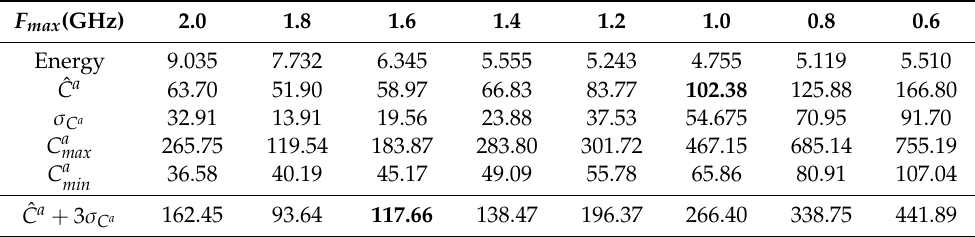
Table 5. Values obtained for performance governor with di ff erent F max values. Vid3.